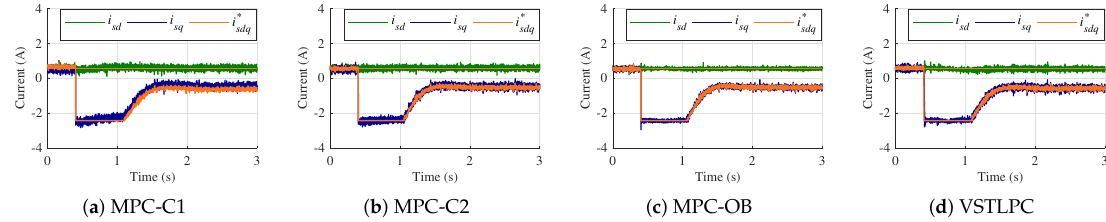
Figure 7. Evolution of d – q currents and their references for each controller in a reversal test from − 500 rpm to 500 rpm with a load torque of the 60%.